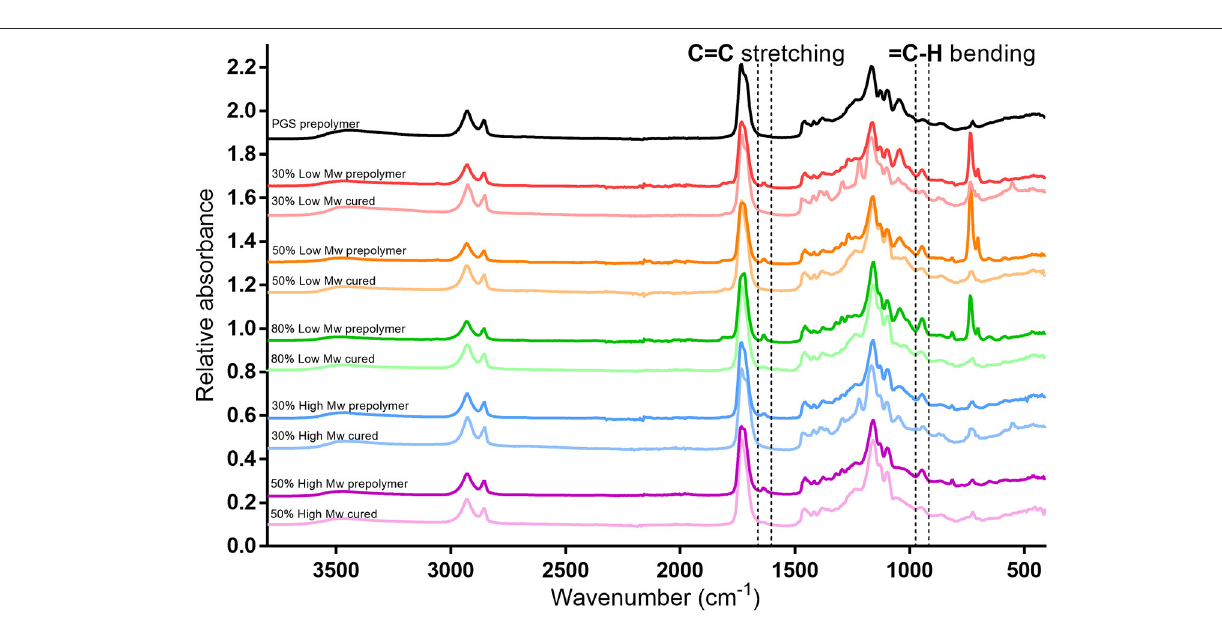
FIGURE 6 | ATR-FTIR spectra for PGS and PGS-M prepolymer at various molecular weights and DM. Highlighted are the regions around 940 and 1,639 cm − 1 showing the absorbance peaks associated with the methacrylate group C = C bond present in the PGS-M prepolymers. These peaks are absent after the prepolymers are